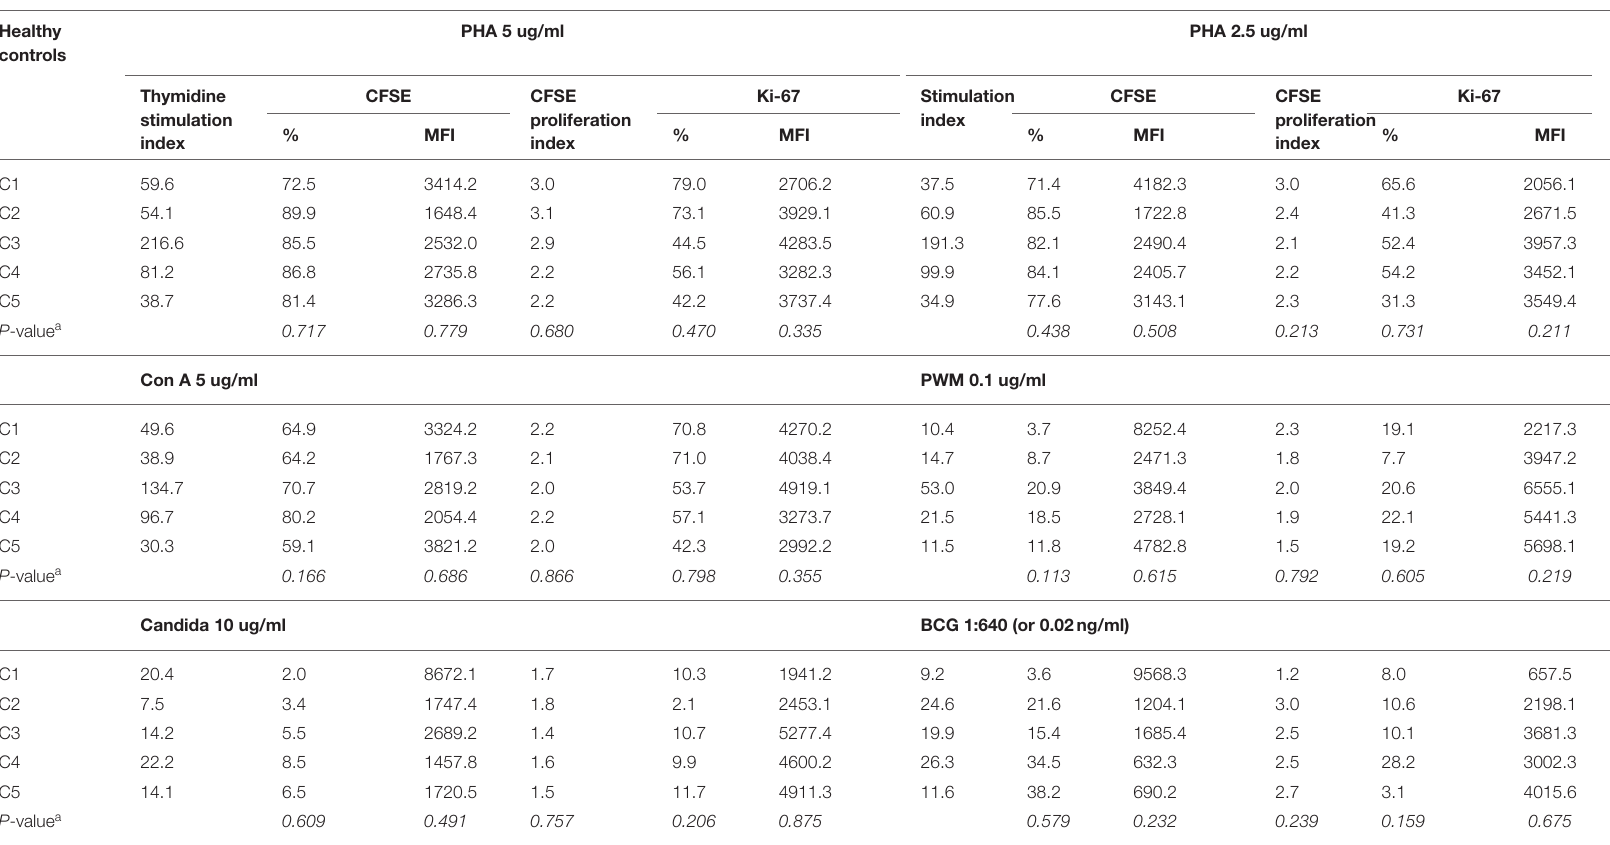
TABLE 1 | The correlation of mitogen- and antigen-stimulated lymphocyte proliferation as detected by [ 3 H]-thymidine, carboxyfluorescein diacetate succinimidyl ester (CFSE), and Ki-67 assays. Healthy